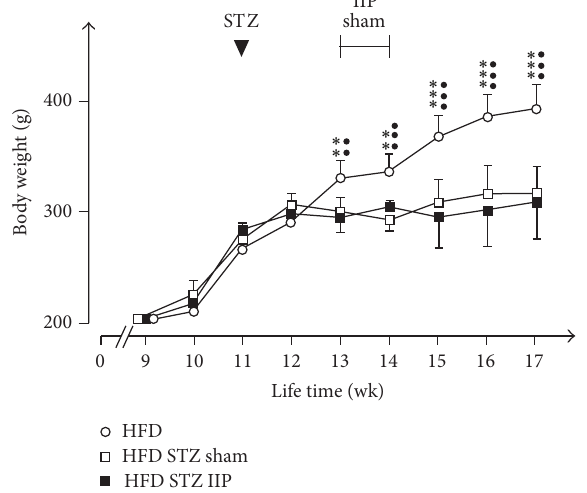
Figure 2: Effects of HFD, STZ treatment, and IIP surgery on body weight. All 27 animals received HFD starting with their 9th week of life and were treated with STZ after the 11th week of life. Sham or IIP surgery was performed in groups of 9 animals. Mean values ± SEM are indicated. ee 𝑝 < 0.01 and eee 𝑝 < 0.001 difference between HFD and HFD STZ sham animals; ∗∗ 𝑝 < 0.01 and ∗∗∗ 𝑝 < 0.001 difference between HFD and HFD STZ IIP animals.